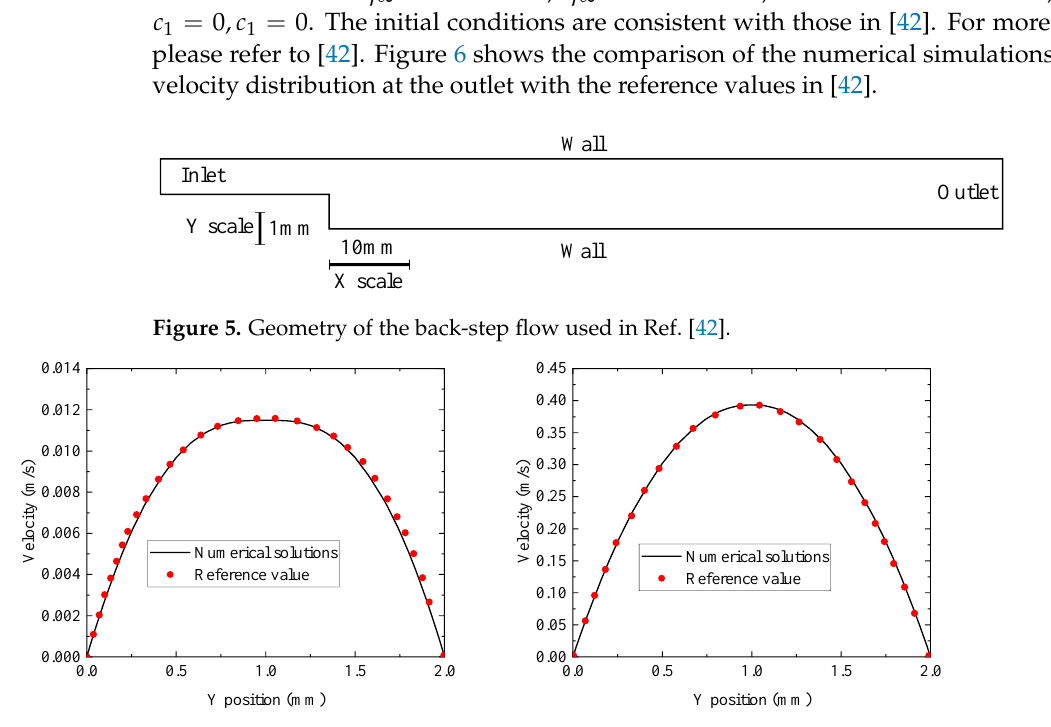
Figure 6. Comparison of the numerical simulation results and the reference value in Ref. [42].